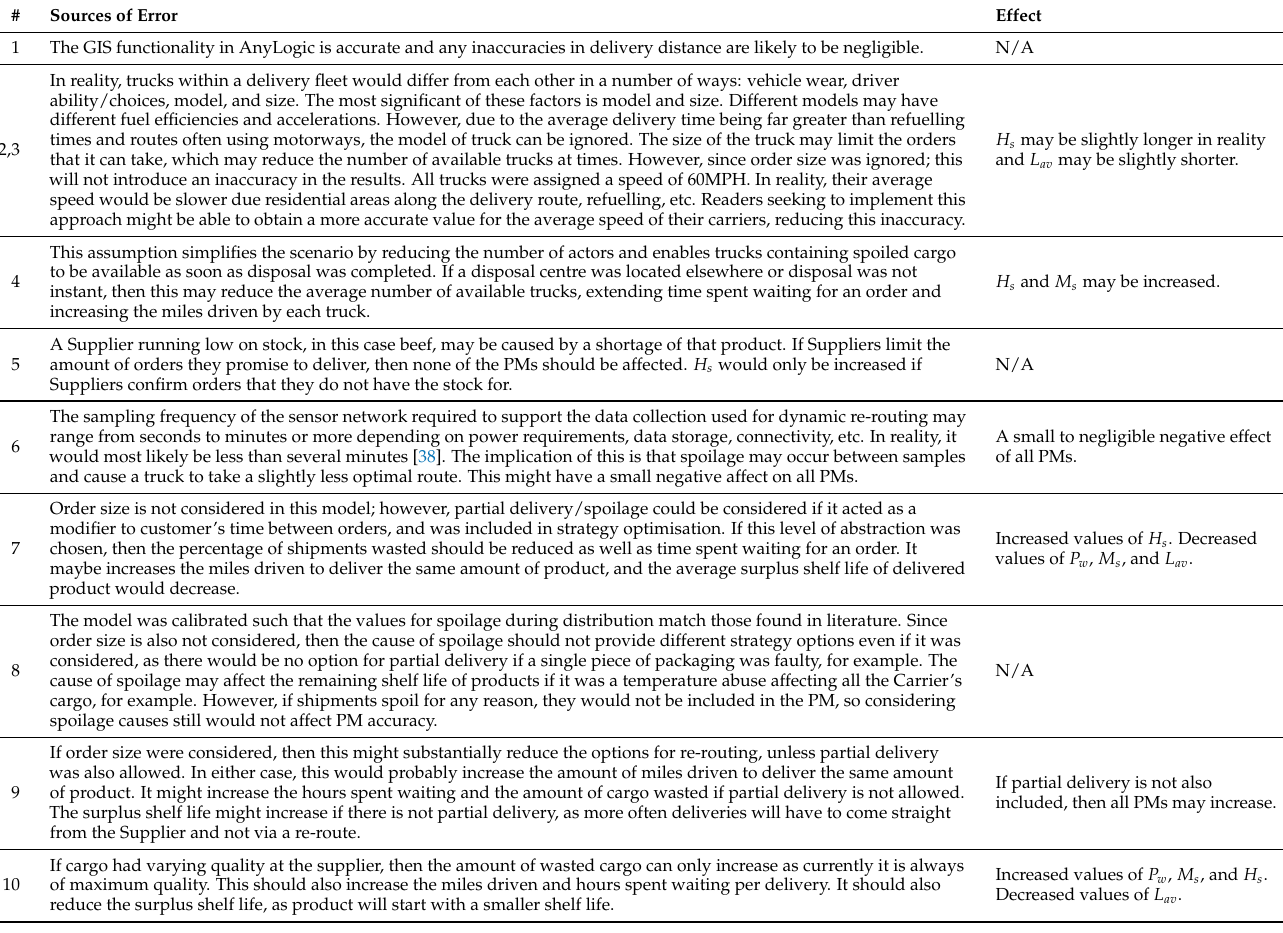
Table 7. Discussion of each assumption and how it might cause inaccuracy in the